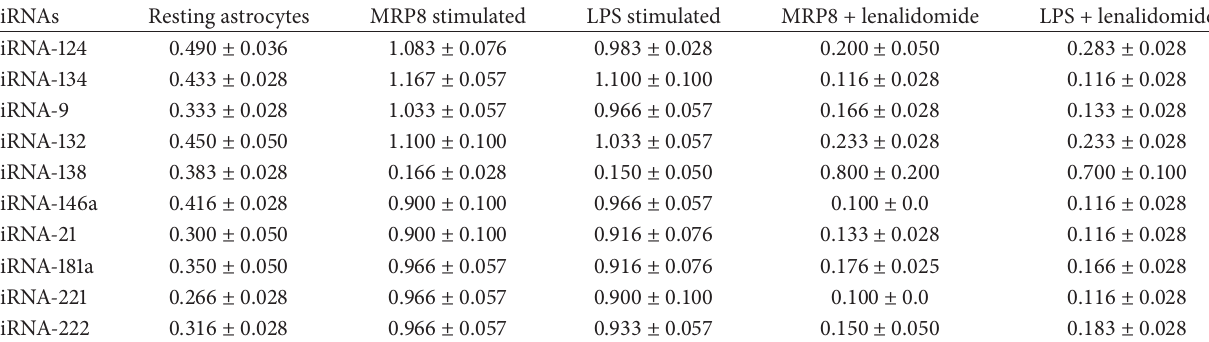
Table 1: Means and SD of the brain-enriched and inflammation-related miRNAs in astrocytes after stimulation with (MRP8 and LPS) and inhibition of TNF- 𝛼 with